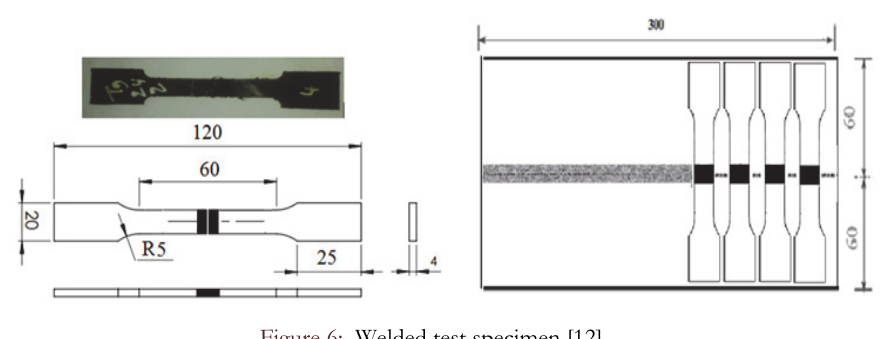
Figure 6: Welded test specimen [12].